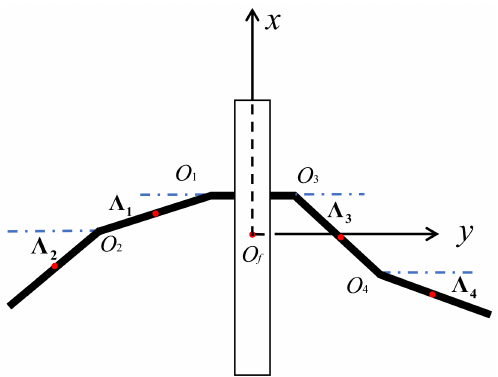
Figure 11. Schematic diagram of the multi-joint variable-sweep UAV system. The fuselage, tail, and weapon section are treated as one rigid